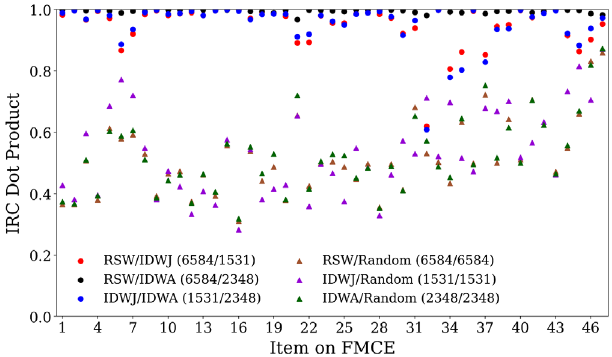
FIG. 3. The IRC dot products for all three pairs of populations shown in Figs. 5, 6, and 7. The IRCs of the American students (RSW and IDWA) are quite similar, and thus the IRC dot product values of the Japanese students (IDWJ) with either set of American students (RSW or IDWA) are similar for each item. IRC dot products are also shown for each population compared to a simulated set of random